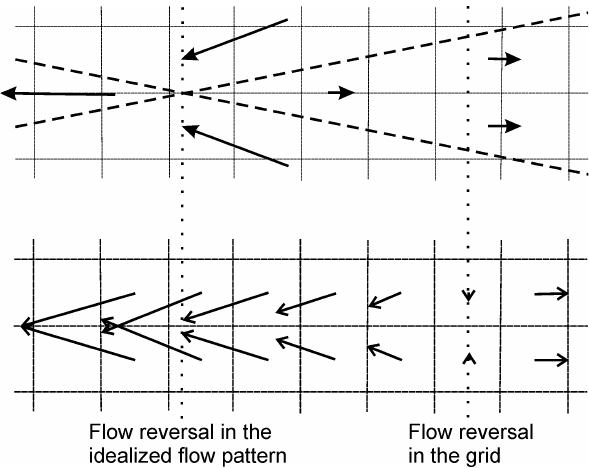
Fig. 6. An idealized flow pattern at the neutral line and its repre- sentation in a simulation grid, showing how averaging of the cell velocities apparently moves the flow reversal